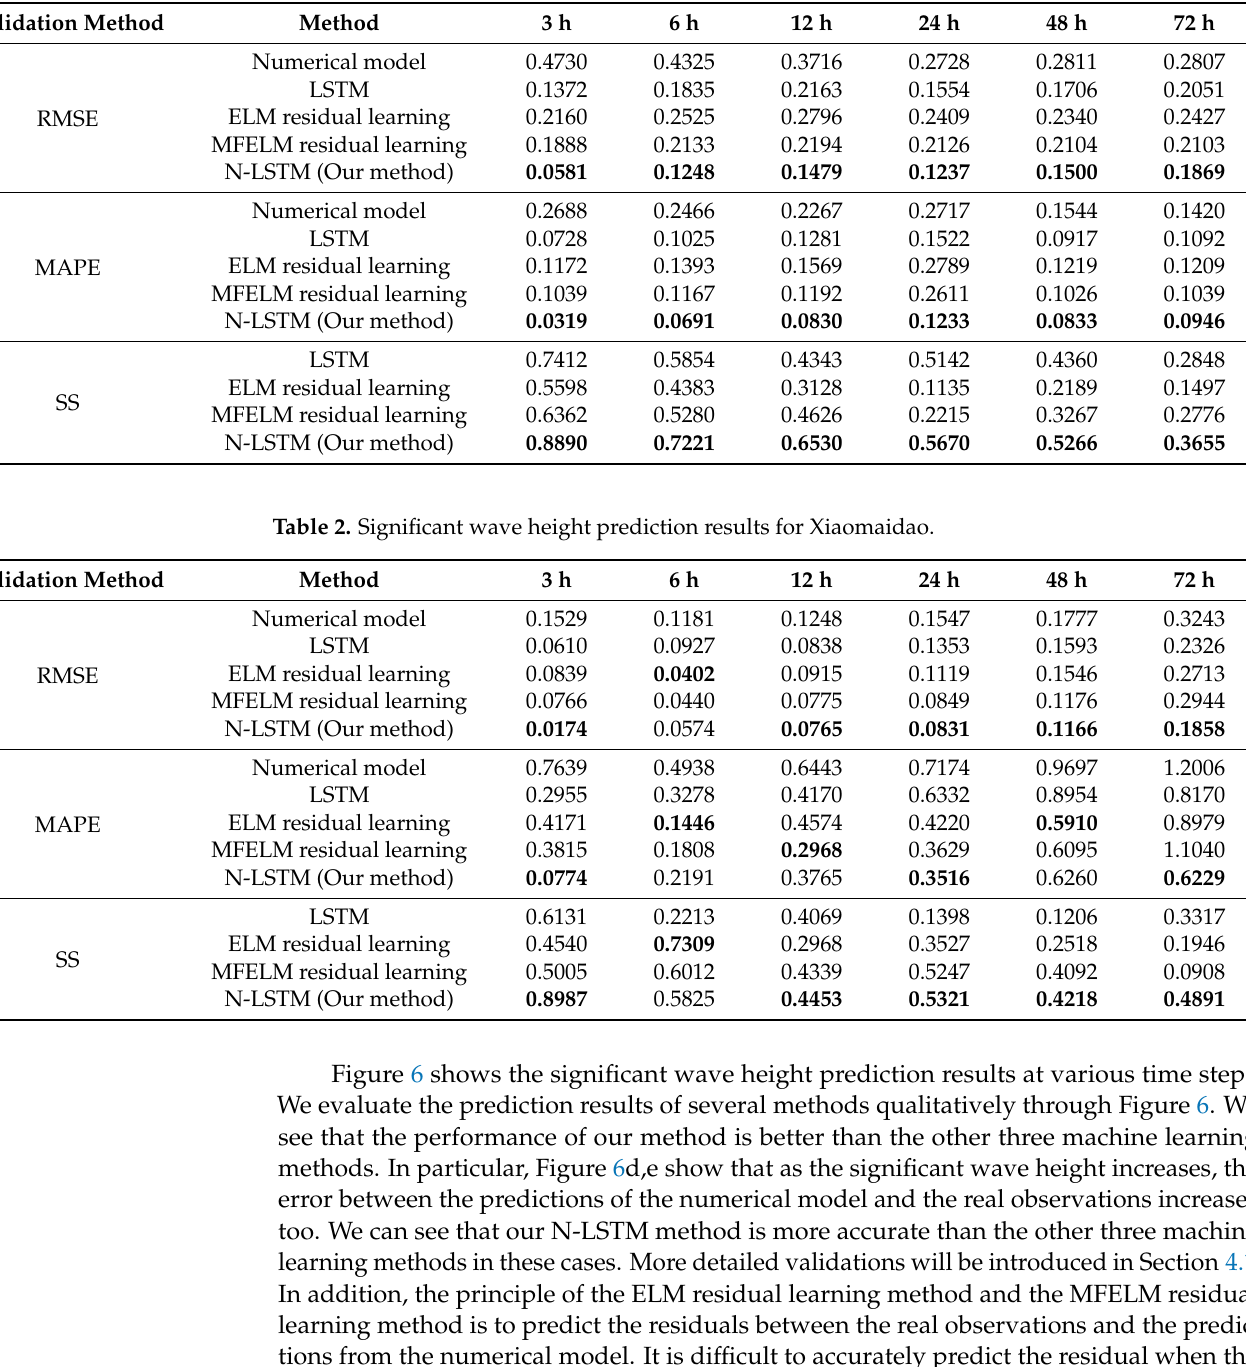
Table 1. Significant wave height prediction results for the buoy position in the Bohai Sea.